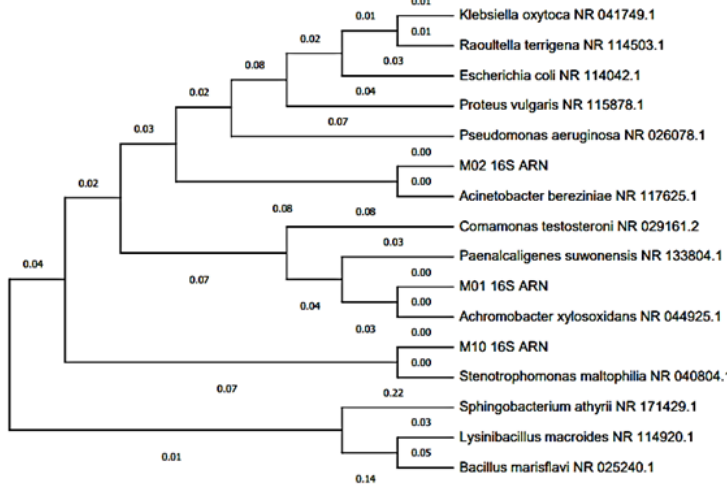
Figure 5. Dendrogram of bacterial clusters isolated from the MFCs anode plate.